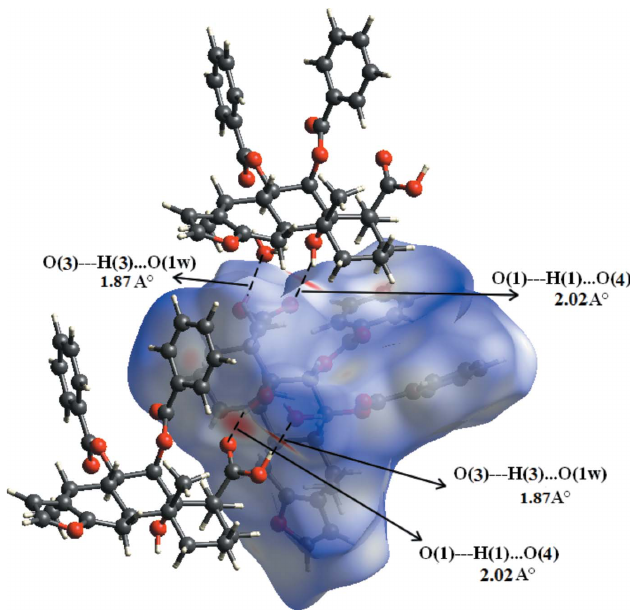
Figure 4 Hirshfeld surface mapped over d norm for the title compound with neighbouring molecules linked via O—H (cid:2)(cid:2)(cid:2) O hydrogen bonds (dashed lines).